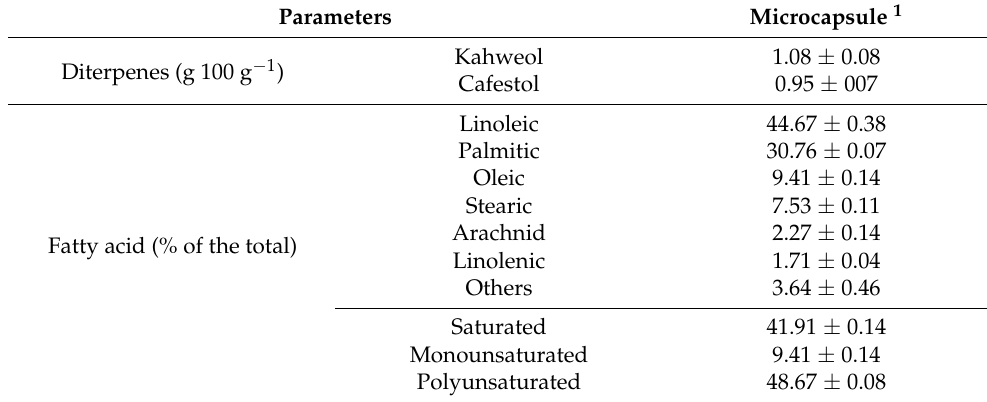
Table 3. Characterization of diterpenes and fatty acids profile of roasted coffee oil microcapsules.